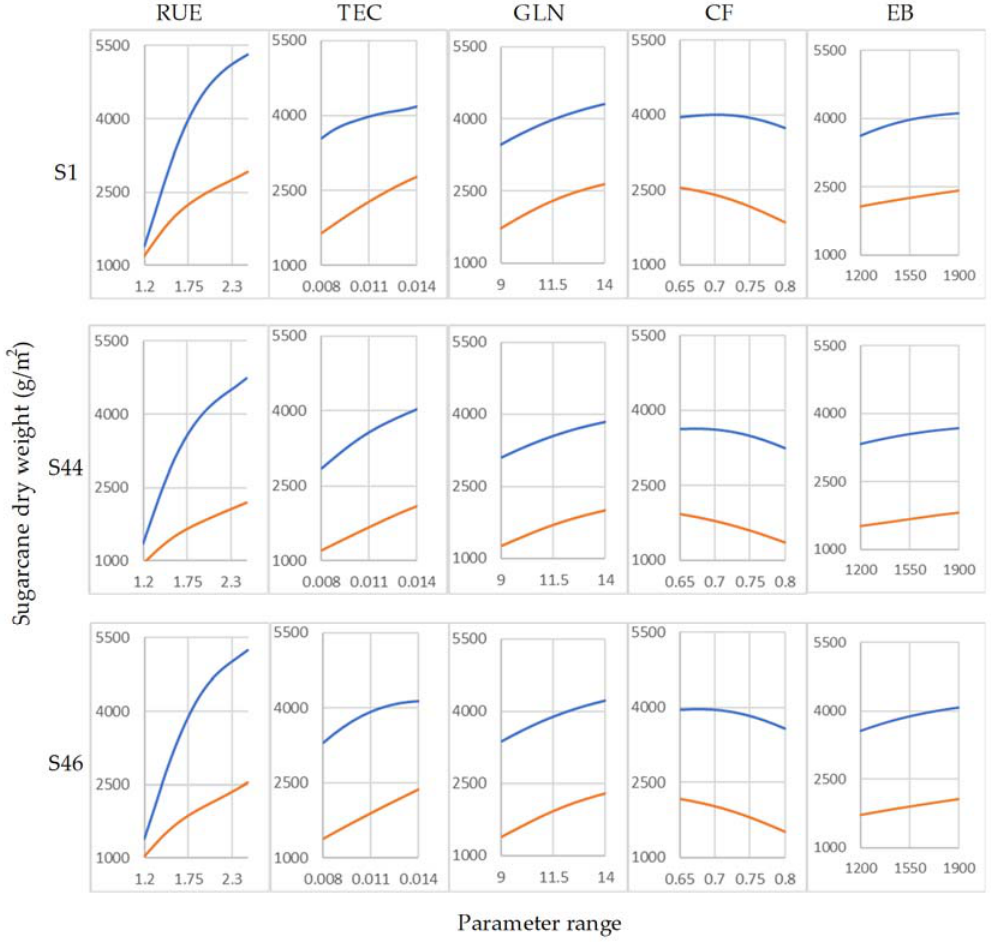
Figure 6. Parameter main effect of highly influential parameters under soil types (S1, S44 and S46), and Ir (blue) and Rf (orange) conditions for CDW.